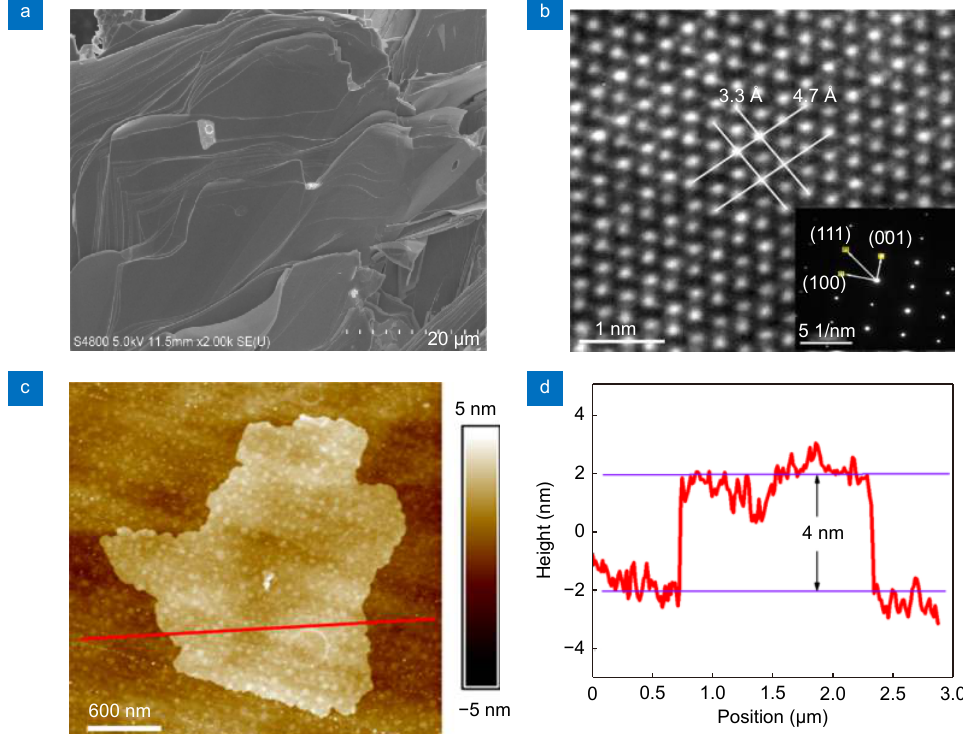
Fig. 1 | ( a ) The SEM image of the layered B-AsP. ( b ) The high resolution TEM (HRTEM) image and the selected area electron diffraction (SAED) pattern of the 2D B-AsP. ( c ) The AFM image of 2D B-AsP. ( d ) The height profiles along the red line in